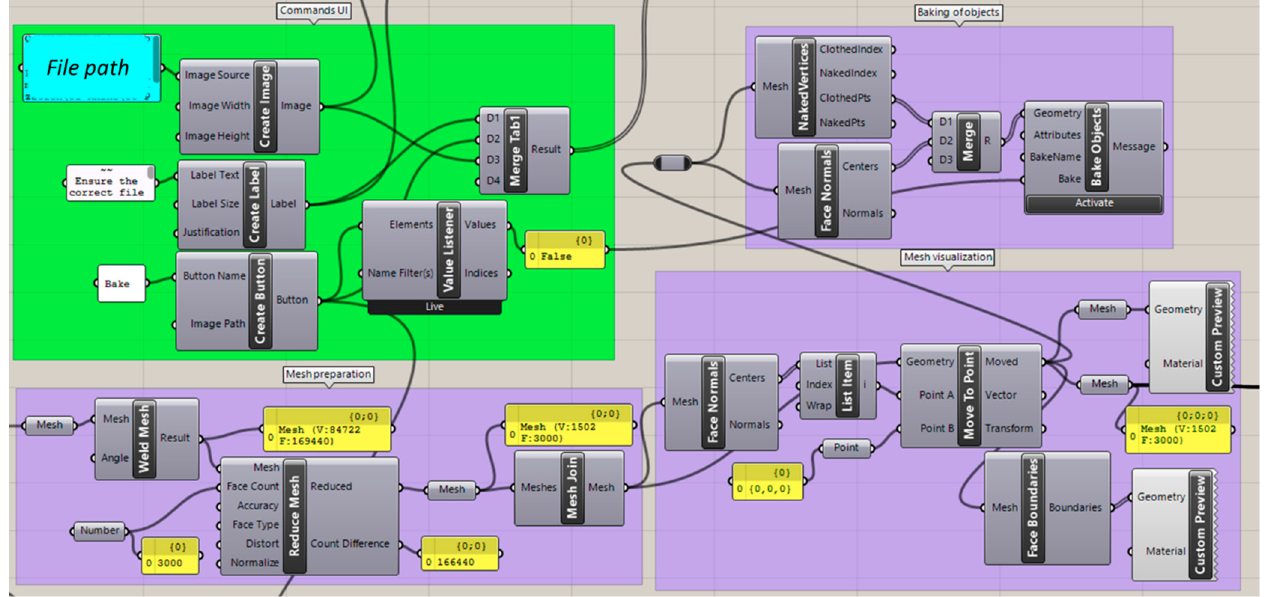
Figure 5. GH command for preparing and processing the mesh. Background colour coding: UI commands (green), conventional GH commands (purple). Panels: customized text (white), file path (blue), control panel (yellow).